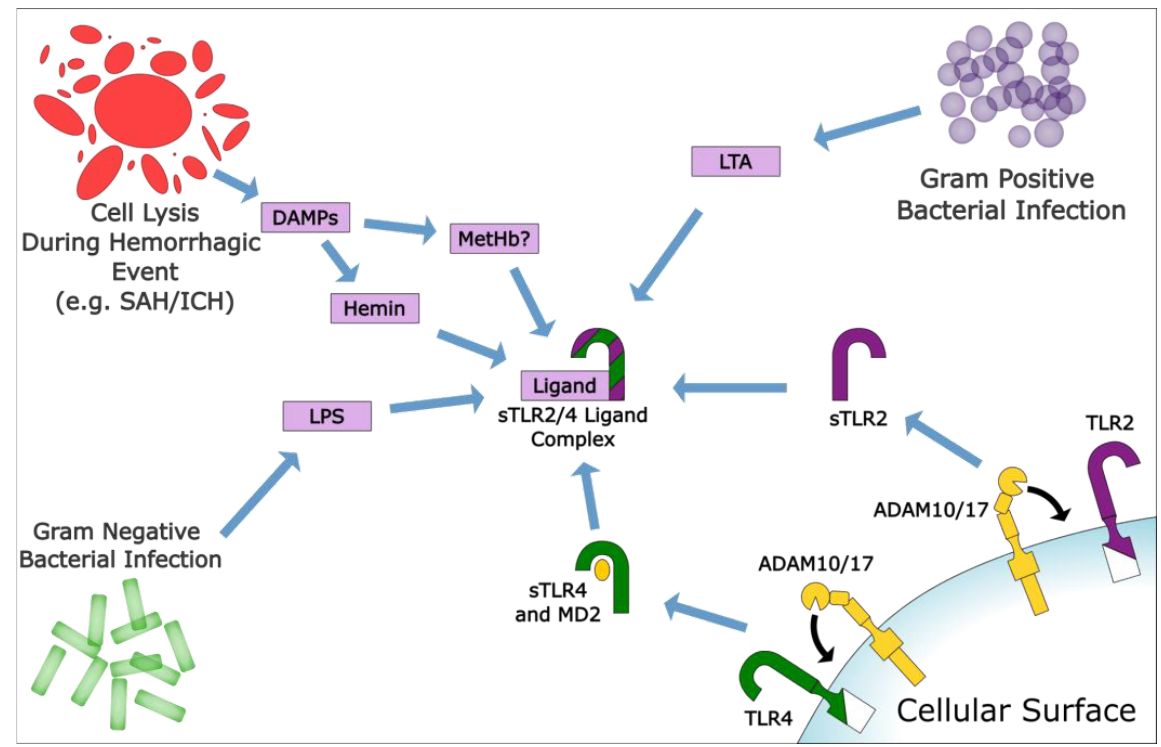
Figure 2. Illustration of the ADAM10/17 cleavage of membrane-bound TLRs to produce soluble TLRs (sTLRs) and the proposed binding of damage-associated molecular patterns (DAMPs) to sTLRs. Note that lipoteichoic acid (LTA) can only bind to TLR2, and the binding of methemoglobin (metHb) to TLRs is a matter of debate.